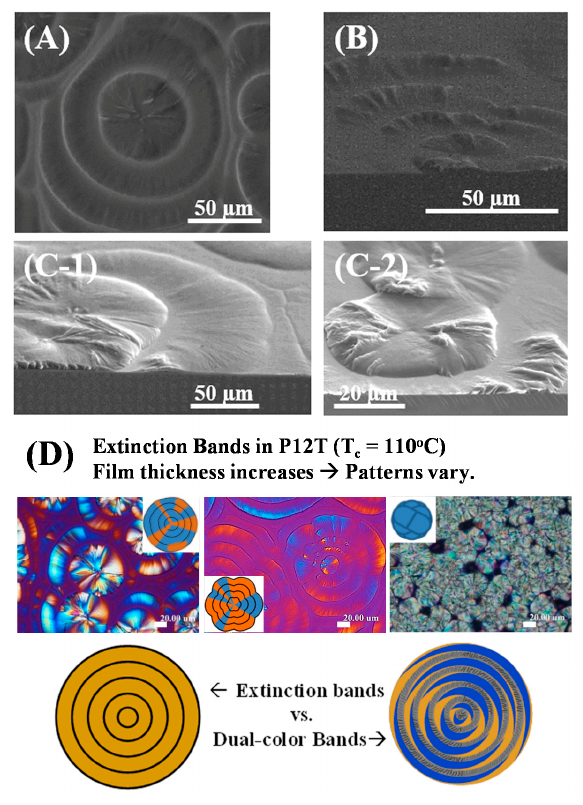
Figure 1. Effect of film thickness on the extinction-banded P12T spherulite patterns crystallized at T c = 110 °C . SEM figures for periodically repetitive flower petals from nuclei with various film thicknesses of ( A ) ~0.5 µm, ( B ) ~1–2 µm, ( C-1 , C-2 ) 3.5 µm, from left to right (scale bars = 20 µm); and ( D ) schemes (from left to right) illustrating the variation of band patterns (black rings indicating a sharp extinction between bands) with increasing film thickness (400 nm–5 µm). The POM image is reproduced with permission from ref. [6].